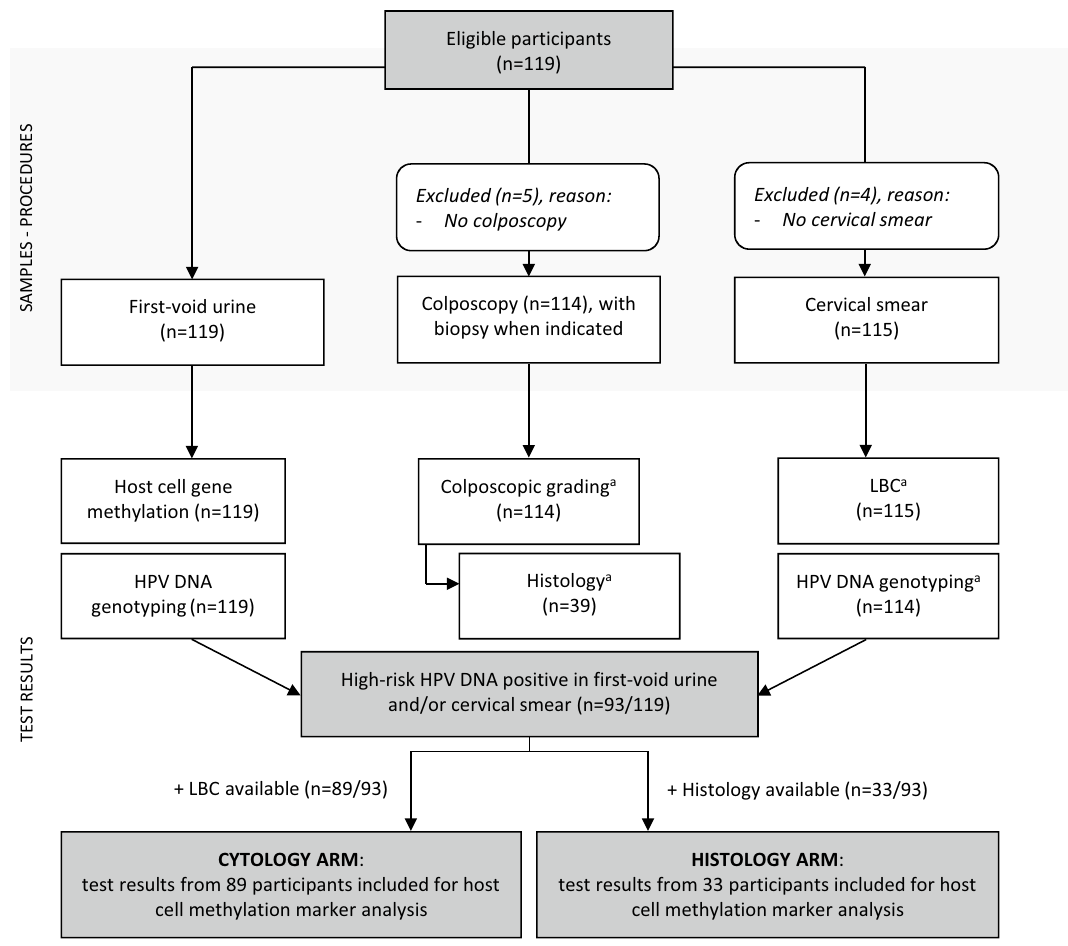
Figure 1. Flow diagram for the inclusion of study participants, samples, and medical records. Results from 119 participants were used for HPV DNA genotyping in first-void urine and cervical samples. Test results from high-risk HPV DNA positive women (in first-void urine and/or cervical smear, n = 93) were used to examine methylation marker performance; using either cytology results (CYTOLOGY ARM), or histology outcomes (HISTOLOGY ARM) as reference. a When unavailable at D0 (day of study visit, i.e. first-void urine collection), the HPV DNA genotyping, liquid based cytology (LBC), colposcopy, and/or histology results from D0 ± 3 months were included for data analysis instead. Thus, three additional HPV DNA genotyping results were included, as well as four LBC and colposcopy, and six histology